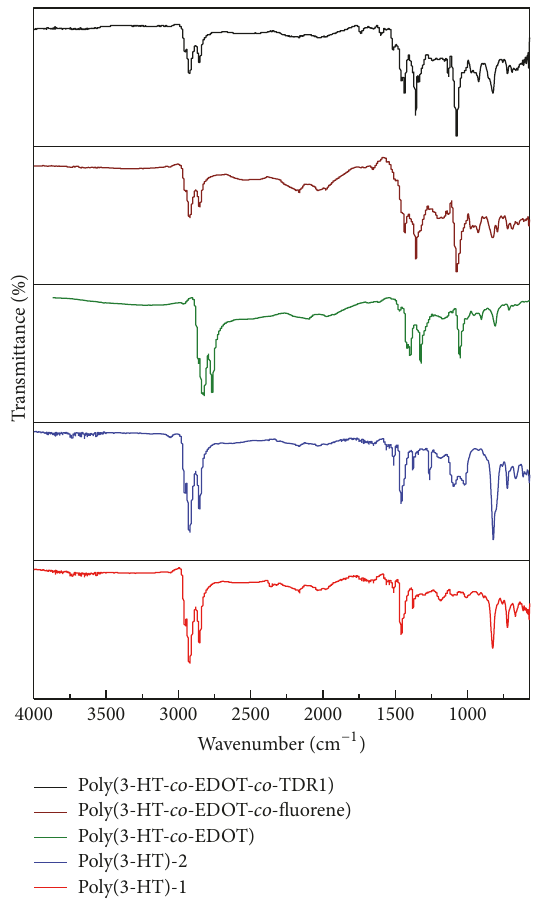
Figure 3: FT-IR spectra of the